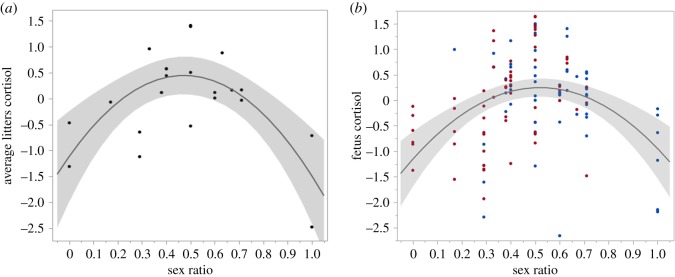
Association between sex ratio in the last trimester and cortisol levels in nutria fetuses. Sex ratios vary between 0 (all-female litter) and 1 (all males). Fetal cortisol was transformed using the Johnson SI (for litter averages) and Johnson Su (for fetuses) transformations, in a model including pregnancy stage and litter size. Distribution of sex ratios is normal, average sex ratio is 0.48, which is not significantly different than even sex ratios (i.e. 0.5). (a) Average litter cortisol levels; (b) individual fetus cortisol levels (males in blue, females in red). Grey area indicates 95% confidence intervals of the second-degree polynomial fit.